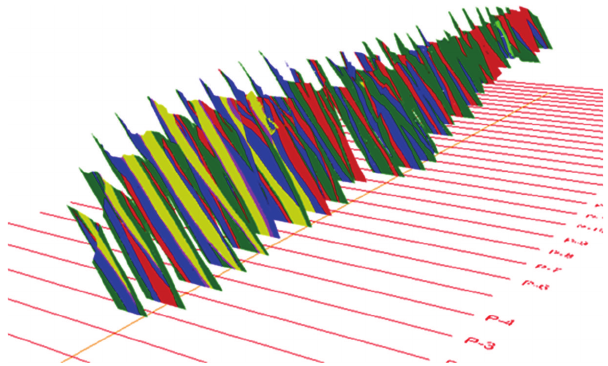
Figure2:Profiles100metresequidistantconstructedforapplication of the method. Grades are indicated as follows: silicon metal (blue), ferrosilicon (red), aggregate (green) and kaolin